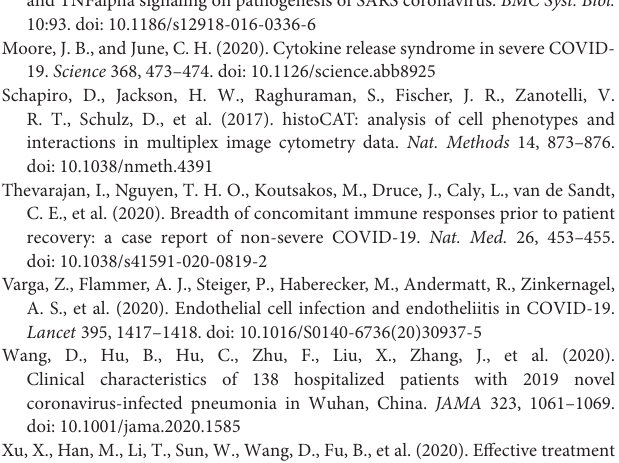
Supplementary Figure 2 | Immune cell responses to severe acute respiratory syndrome coronavirus 2 (SARS-CoV-2) in the kidneys of patients with coronavirus disease-2019 (COVID-19). Representative imaging mass cytometry (IMC) for each panel, with different colors to distinguish panels; iridium-DNA staining is shown in blue. (A) Monocytes (CD14 and CD68), CD11b + macrophages, CD11c + dendritic cells (DCs), natural killer T (NKT) cells (CD3 and CD56), and B cells (CD19) in the kidneys of controls and patients with COVID-19. (B) Bar plot for the comparison of monocytes (CD14 and CD68), CD11b + macrophages, CD11c + DCs, NKT cells (CD3 and CD56), and B cells (CD19) in the kidneys of controls and patients with COVID-19. The significance of differences between groups is shown as horizontal brackets and was assessed using Fisher’s exact test. ∗∗∗ P < 0.01; ns, P > 0.01.